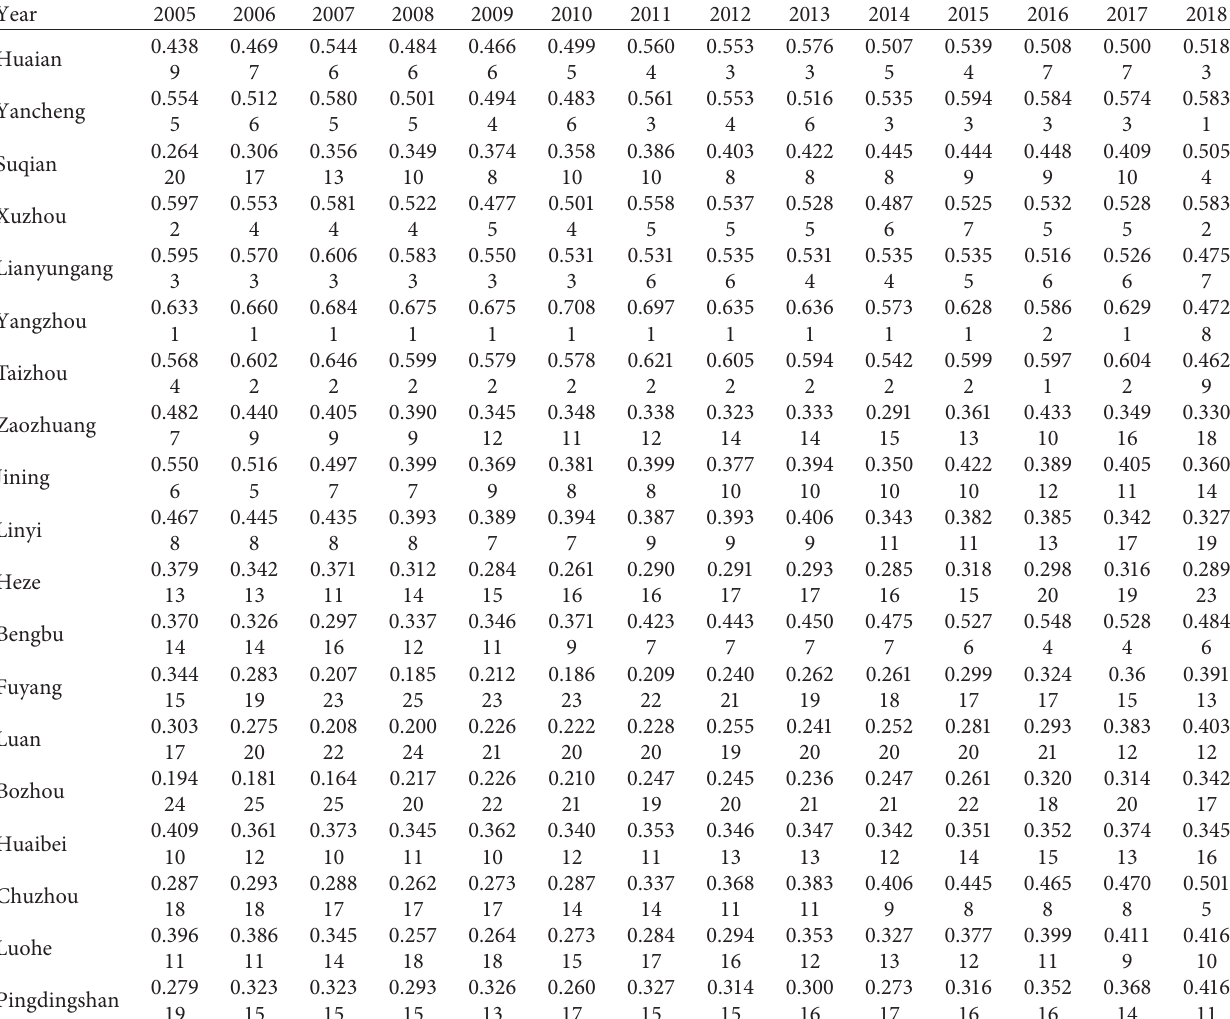
Table 2: Valuation value and ranking of urban competitiveness in Huaihe ecological economic